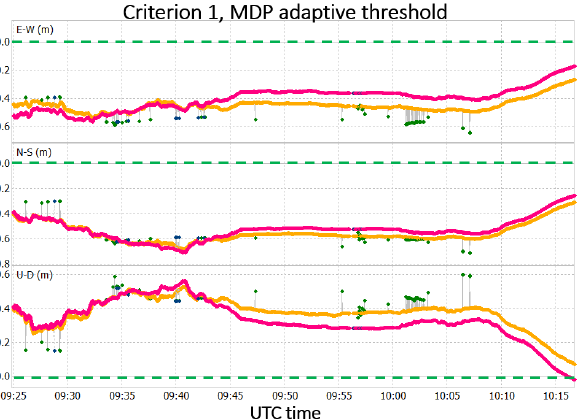
Figure 11. Results obtained after the MDP algorithm application using criterion 1 and adaptive MDP threshold.